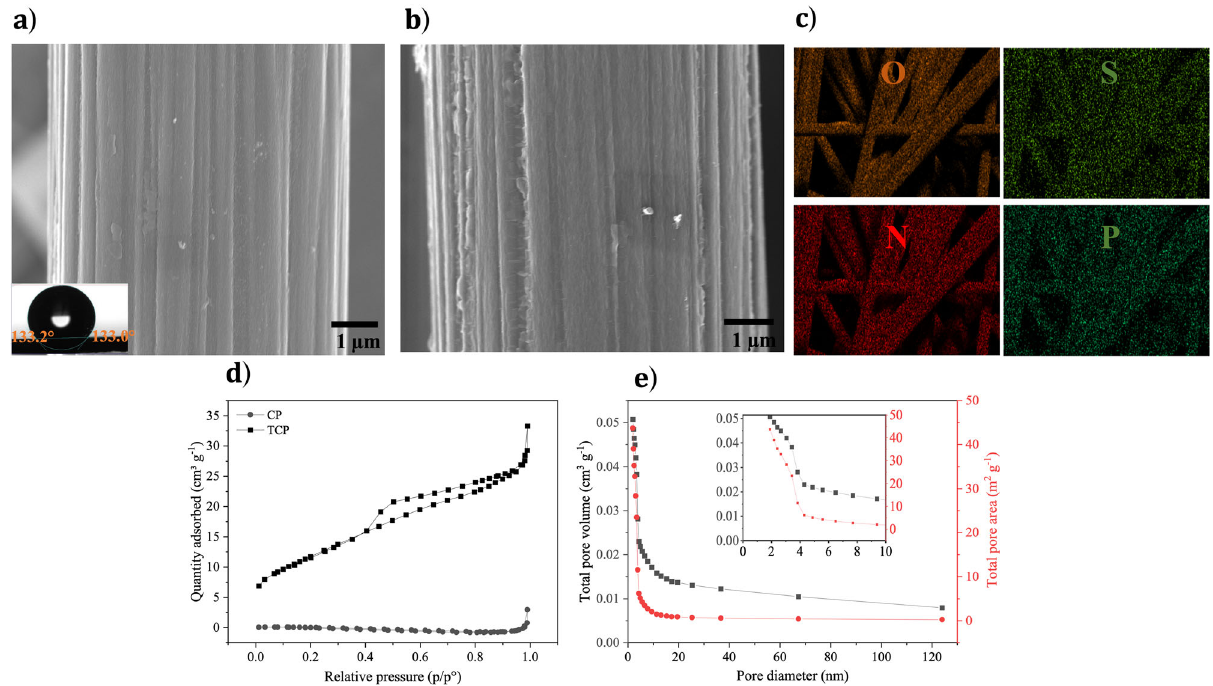
Fig. 2 Morphology, elemental composition, surface area and pore size distribution of CP and TCP. SEM images: top view of ( a ) CP, ( b ) TCP, ( c ) EDX mapping of O, N, S, and P elements for TCP at 5 keV, ( d ) N 2 adsorption/desorption isotherms for carbon paper (CP) and treated carbon paper (TCP), and